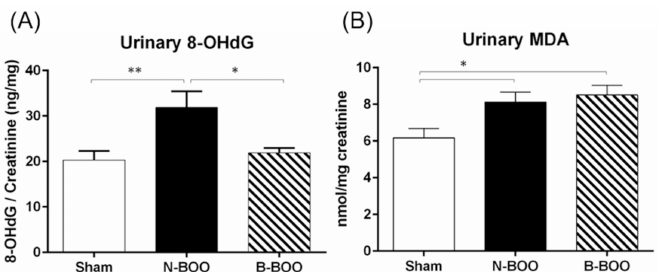
Figure 2. Anti-oxidative e ff ect of blueberries on urinary 8-OHdG ( A ) and malondialdehyde (MDA) ( B ). A single asterisk indicates p < 0.05. Double asterisks indicate p < 0.01.